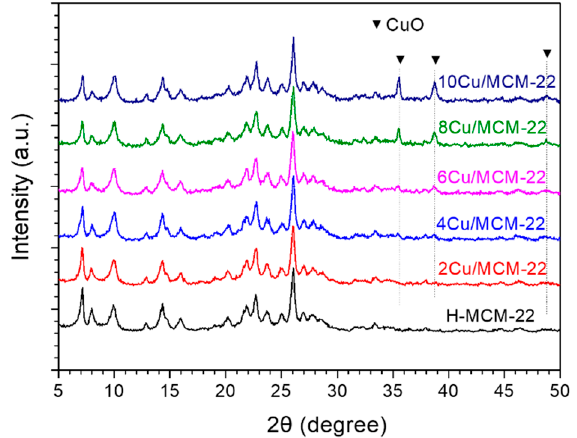
Figure 1. SEM images of H-MCM-22 ( a ) and x Cu/MCM-22 zeolites: ( b ) 2Cu/MCM-22, ( c ) 4Cu/MCM-